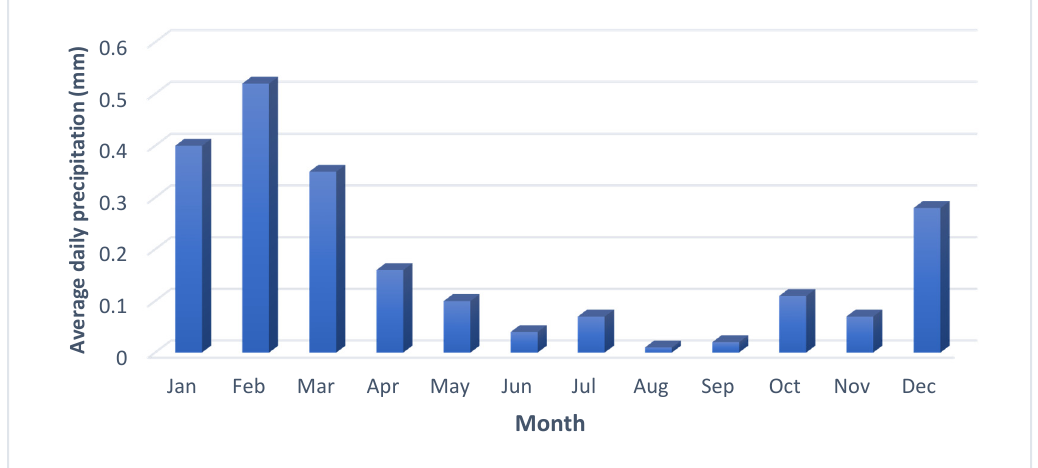
Figure 2. Average daily precipitation data collected from three meteorological stations in the Sistan and Baluchestan province based on the average values of the last 20 years[36].